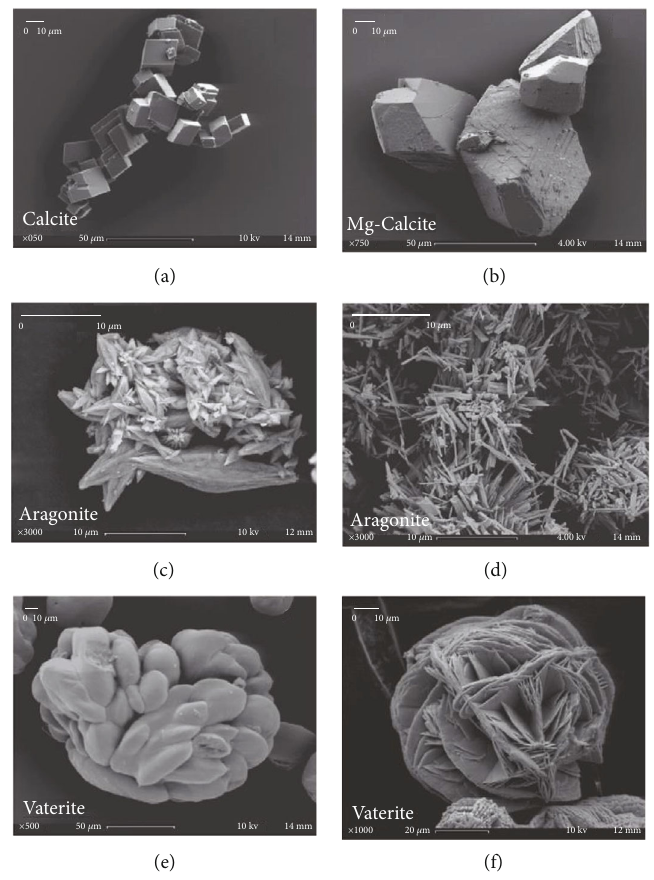
(reprinted from Niedermayr et al. [24]). 3